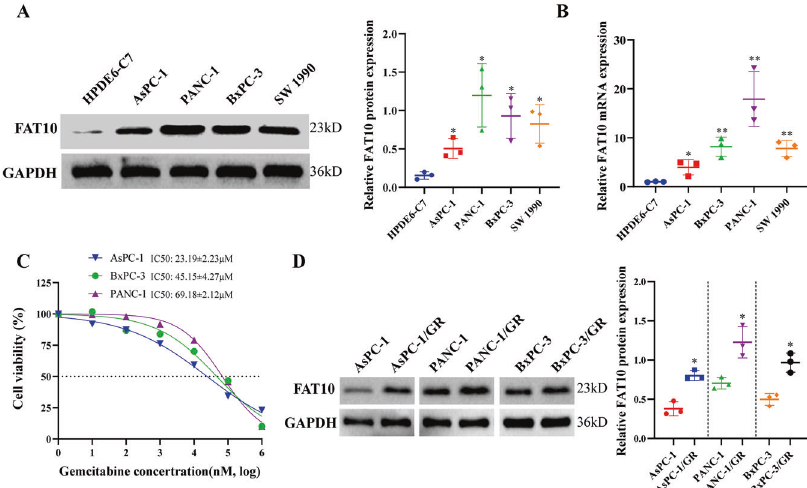
Fig. 2 FAT10 expression is correlated with chemoresistance of PC cells to GEM. A Protein expression of FAT10 in noncancerous pancreatic ductal epithelial cells and PC cell lines was analyzed by western blotting. B The mRNA expression of FAT10 in normal pancreatic ductal epithelial cells and PC cell lines was analyzed by qRT – PCR. C Viabilities of PC cells were determined in response to different concentrations of GEM. Inhibition curves were fi tted by nonlinear regression, and GEM IC50s were calculated using GraphPad Prism 8 software. D Western blotting was used to analyze expression levels of FAT10 in GEM-resistant (GR) PC cells. Data represent the mean ± SD of triplicate experiments and were statistically analyzed with Student ’ s t-test, * p < 0.05, ** p <